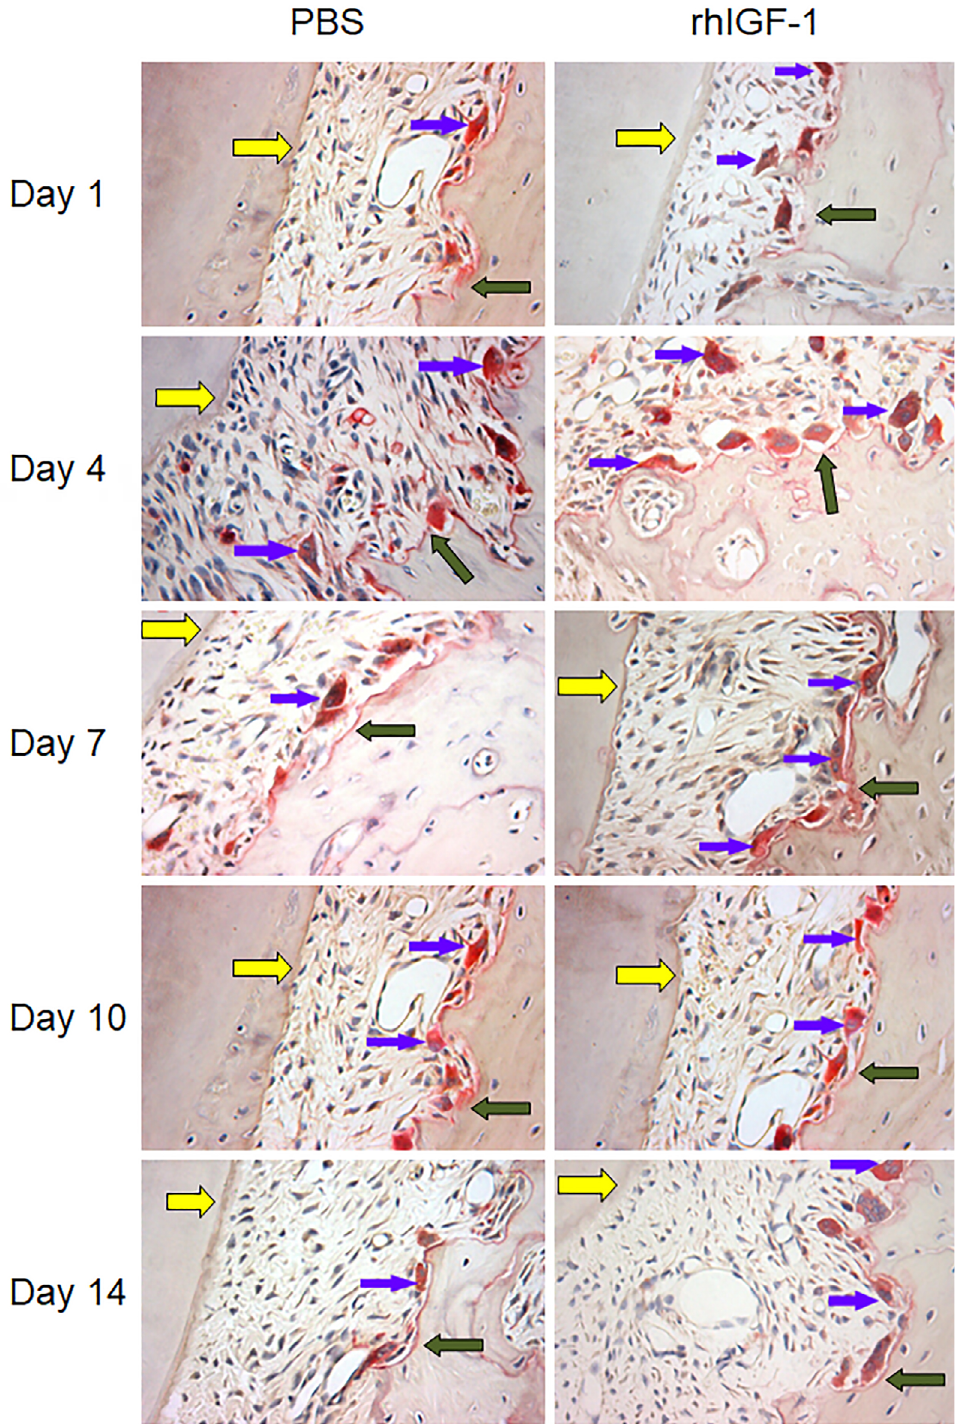
Figure 2- Histological observations of osteoclasts on the compression side. The red areas shown by the blue arrow are osteoclasts, the blue arrows indicate osteoclasts in red stained for TRAP, the yellow arrows indicate the cementum, and the green arrows indicate the alveolar bone. Magnification,